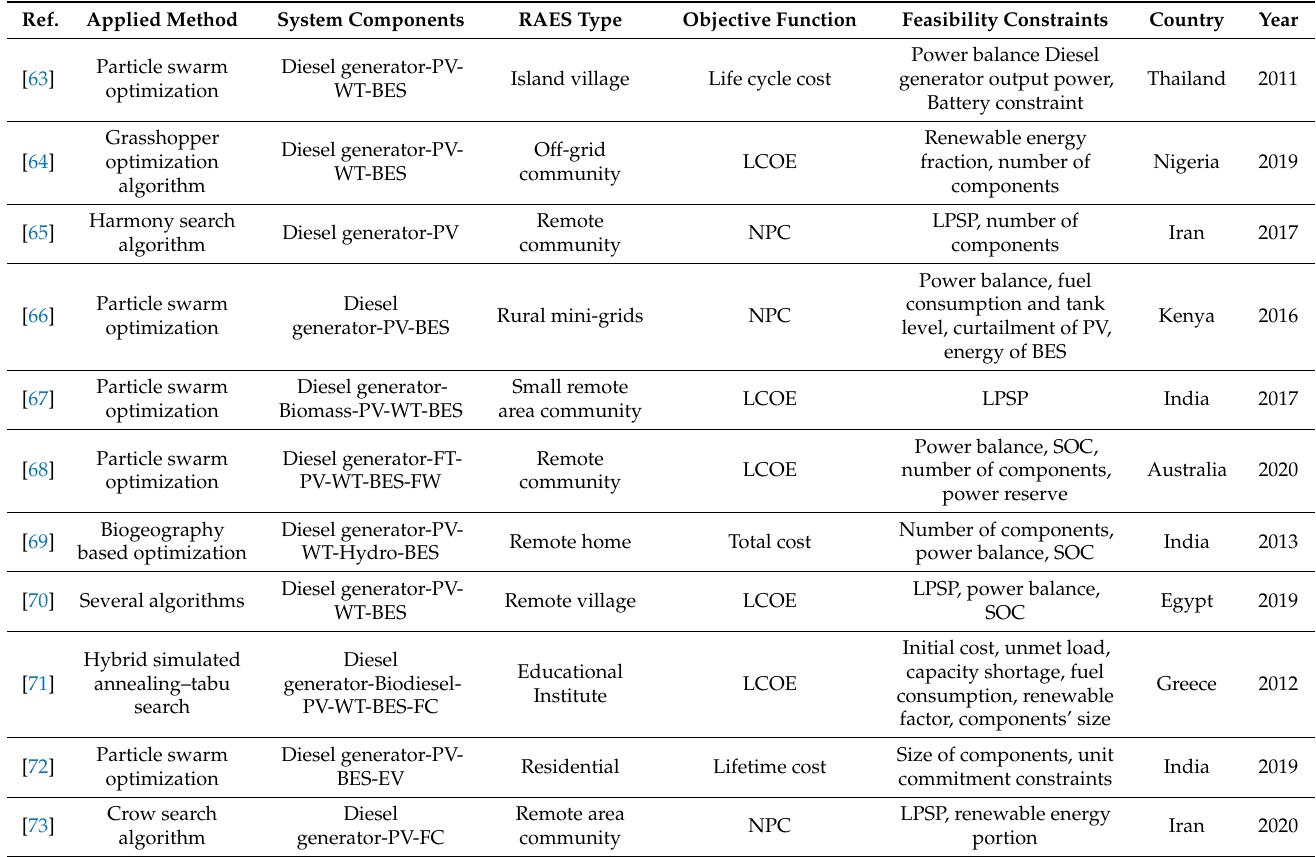
Table 4. Characteristics of studies on single-objective optimal planning for hybrid RAES systems. Ref.